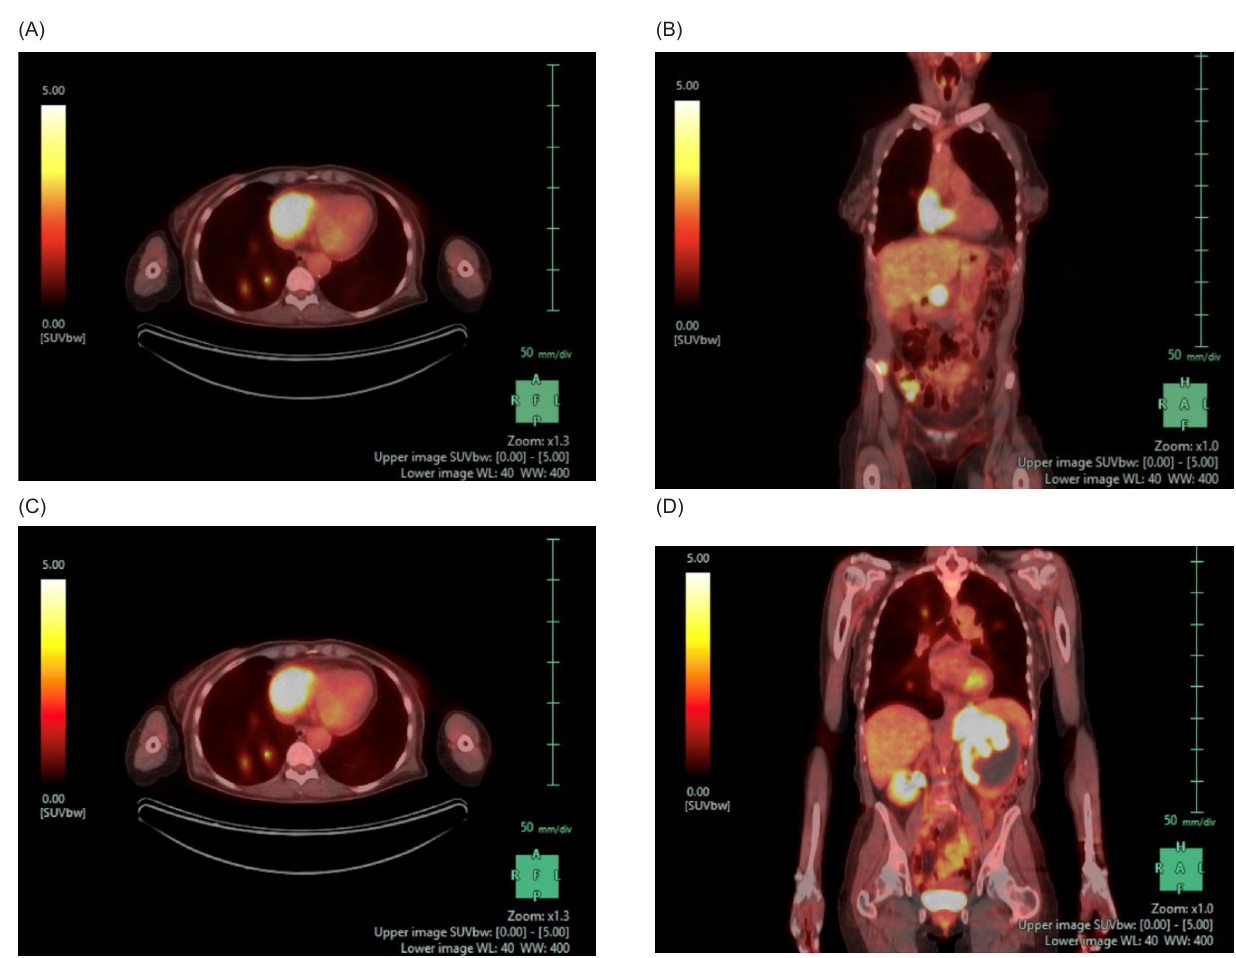
Figure 2: PET-CT of the chest, abdomen, and pelvis. (A) Axial and (B) coronal views demonstrating a FDG uptake of the right atrium suggestive of a cardiac metastasis. There are also FDG avid pulmonary nodules. (C) Axial and (D) coronal views demon- strating a heterogeneously attenuating 9.6 × 8.7 cm left renal mass and accompanying 5.9 × 4.3 FDG avid adrenal mass. There is also a 2.6 × 1.2 cm FDG avid right adrenal metastasis and multiple FDG avid abdominopelvic nodules.